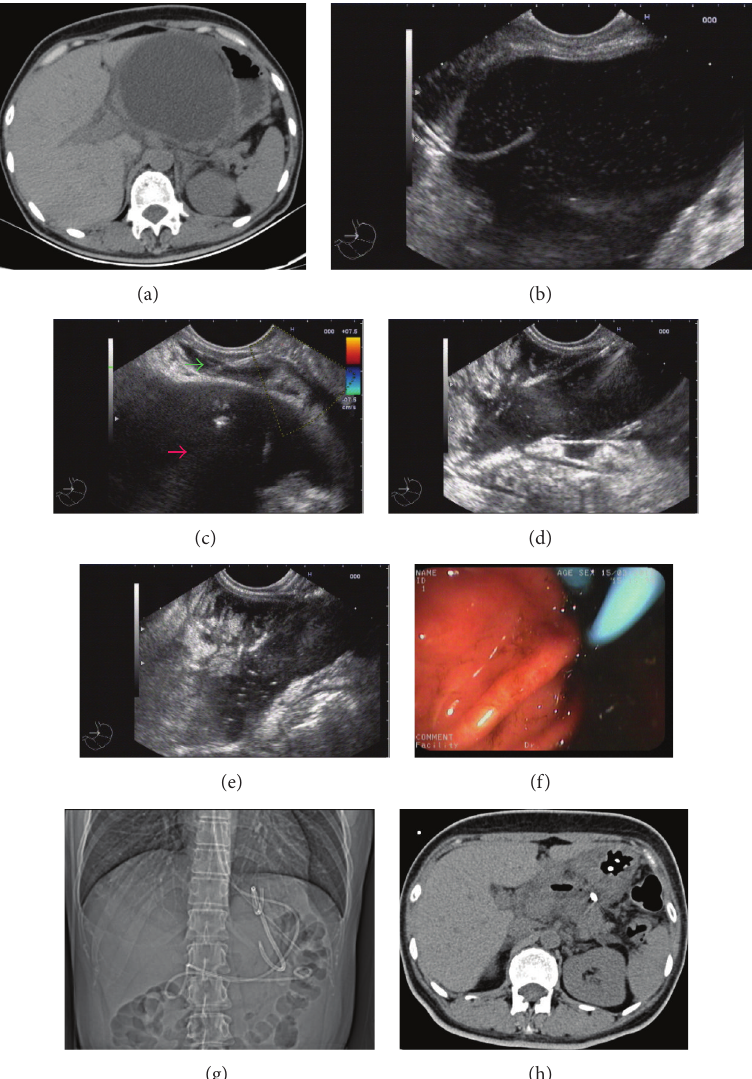
Figure 1: (a) CT shows a large cyst in the upper abdominal area. (b) EUS shows the cyst wall was 3 mm. The wall was not adhered to the gastric wall, as relative movement was observed. (c) After the needle puncture, cyst (red arrow) fluid will leak into the omental bursa. After cystotome dilation and stent placement, fluid leak (green arrow) begins to increase. (d) A large collection of fluid, measuring 3 cm, is seen below the cyst. (e) Transmural approach by a cystotome. (f) Intraperitoneal drainage by a 7 Fr nasobiliary catheter. (g) Drainage catheters seen on X-ray. (h) Pancreatic pseudocyst size is diminished, as confirmed by